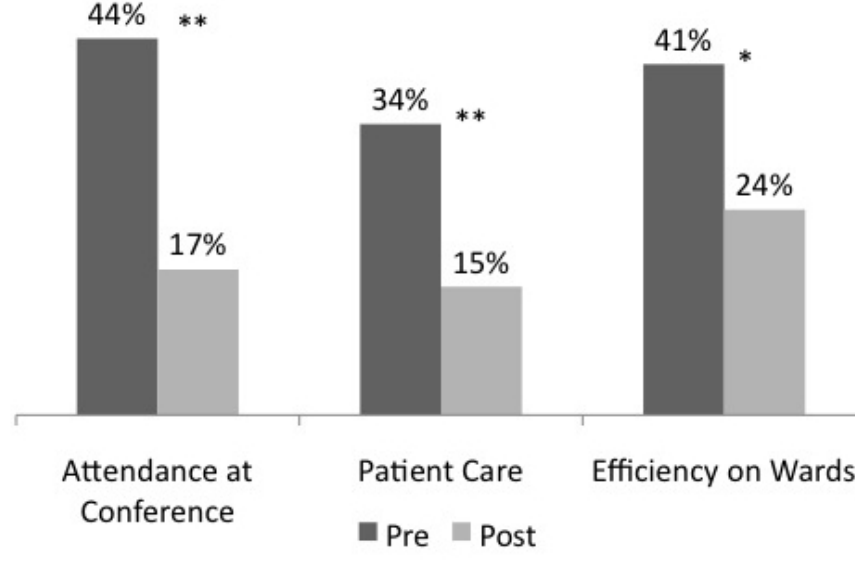
Figure 3. iPad usage by task: Hype versus non-hyped residents. * P =.01, chi-square tests. ** P =.04, chi-square